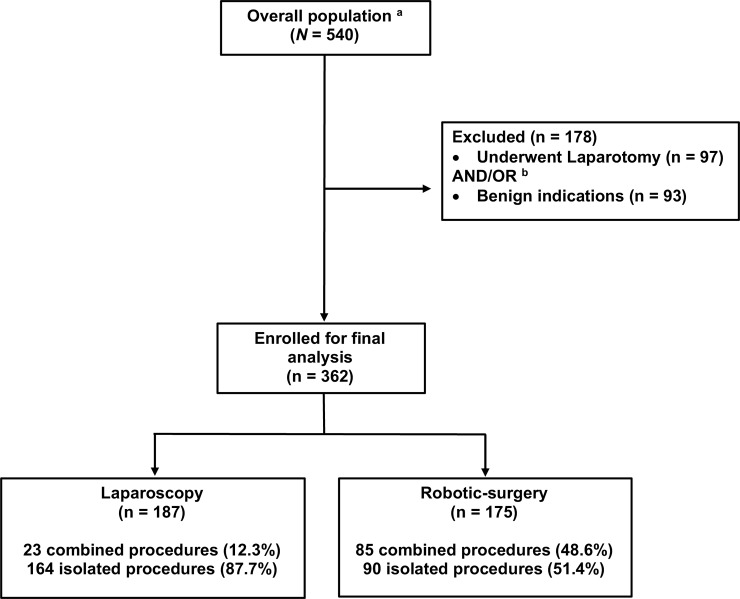
Subject disposition (CONSORT flow diagram).a Overall population was represented by those women who followed the enhanced recovery program between January 2016 and September 2018 b 12 Women underwent laparotomy for benign indications.